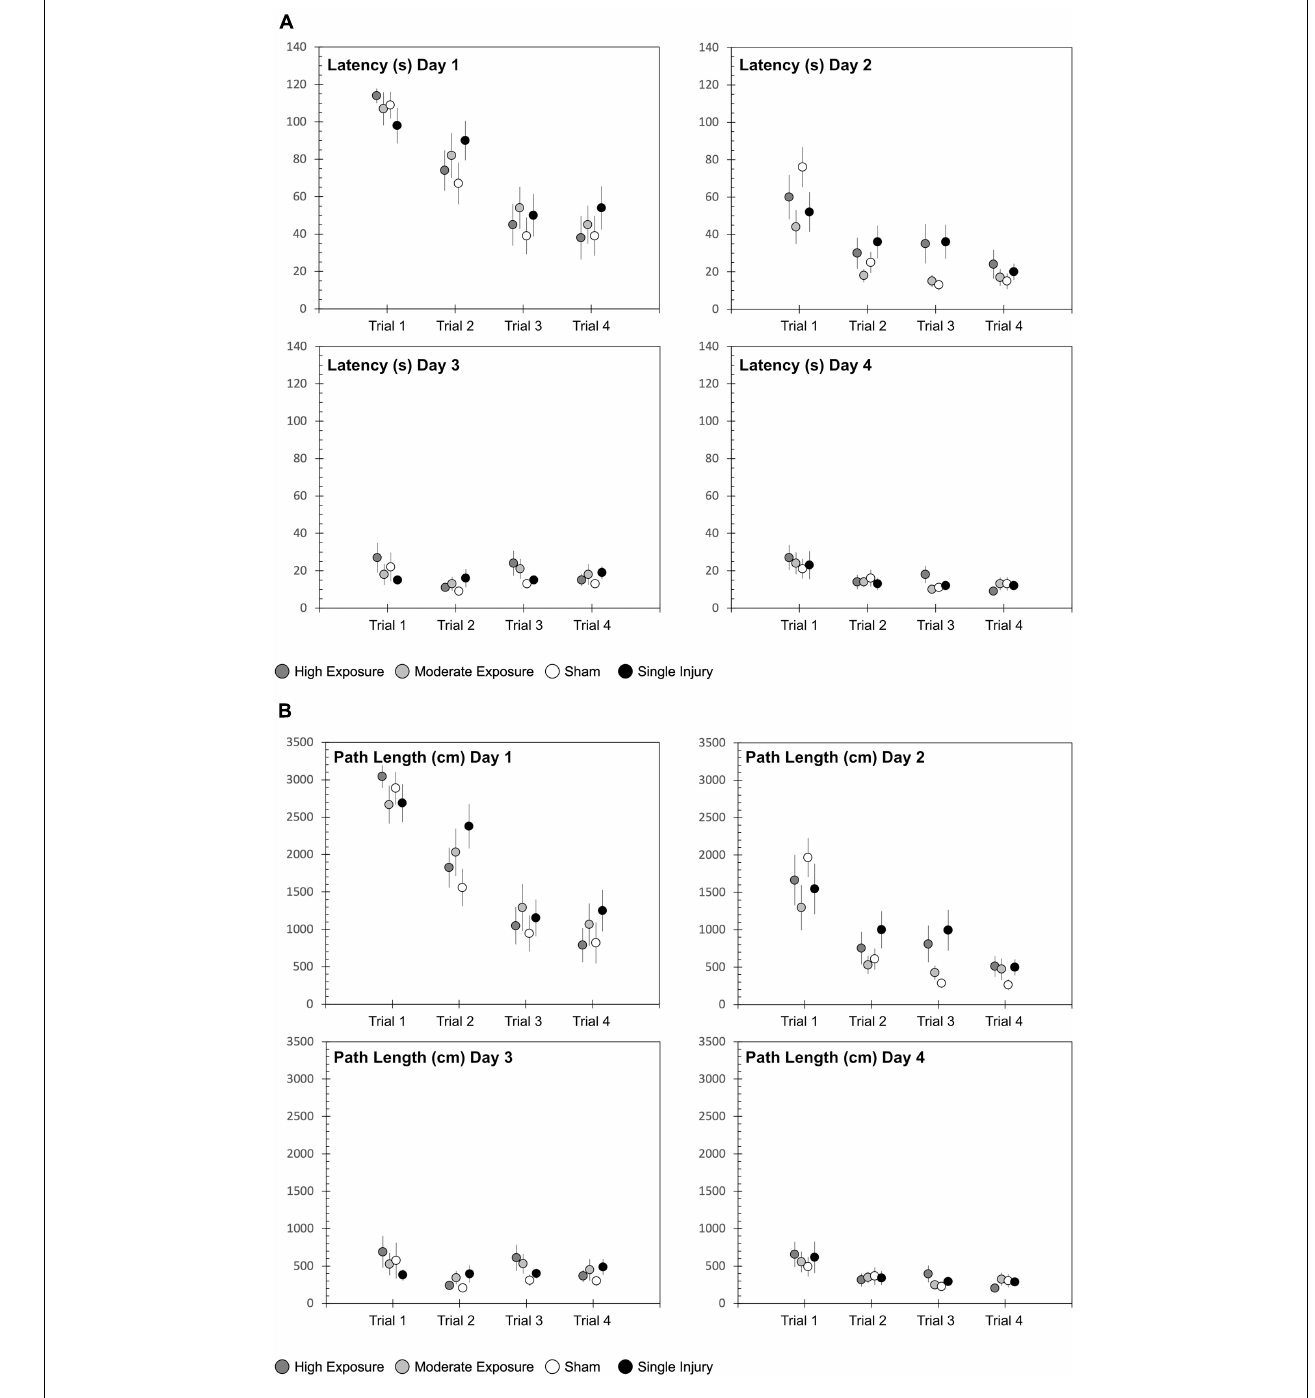
FIGURE 2 | Morris water maze (MWM) (A) latency and (B) path length to find the hidden platform for each of the four experimental groups. The MWM protocol consisted of 4 days of four trials each, conducted over a 4-day period in the week following the exposure protocol, sham protocol, or single injury exposure. Data are presented as mean and standard error for of the four experimental